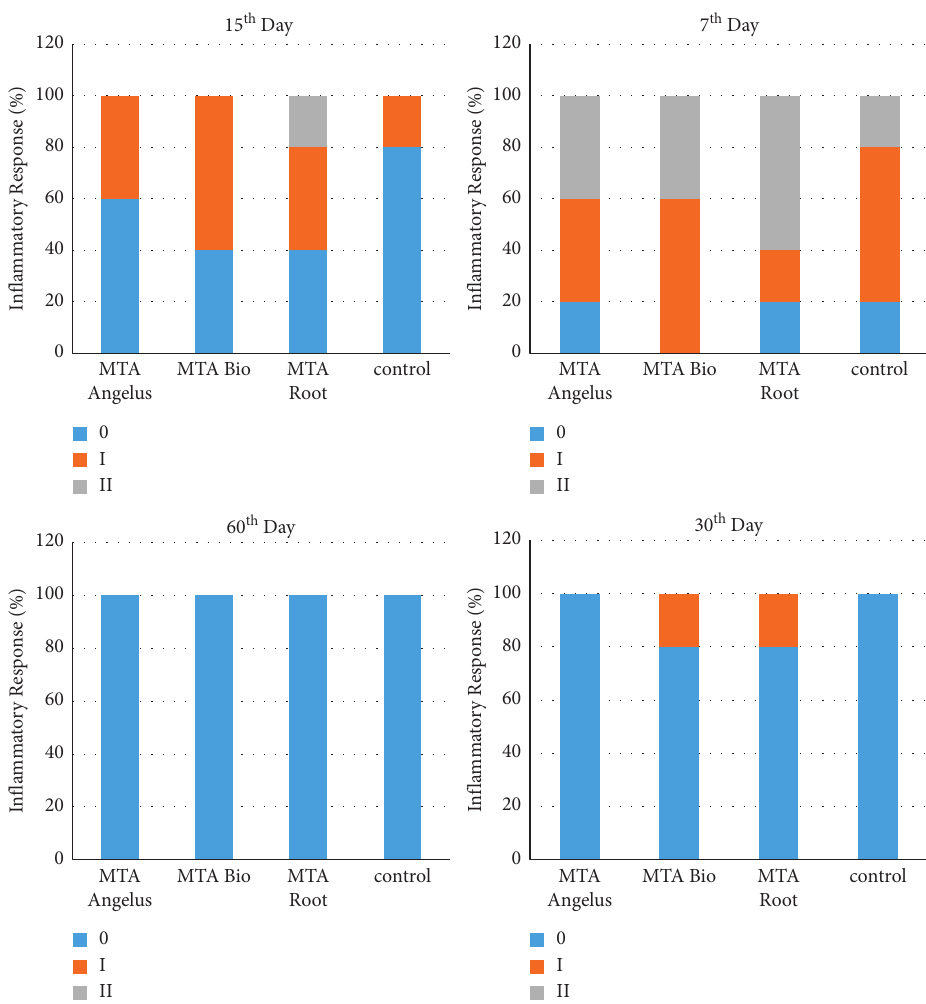
Figure 2: Mean values of inflammatory responses of different groups on days 7, 15, 30, and